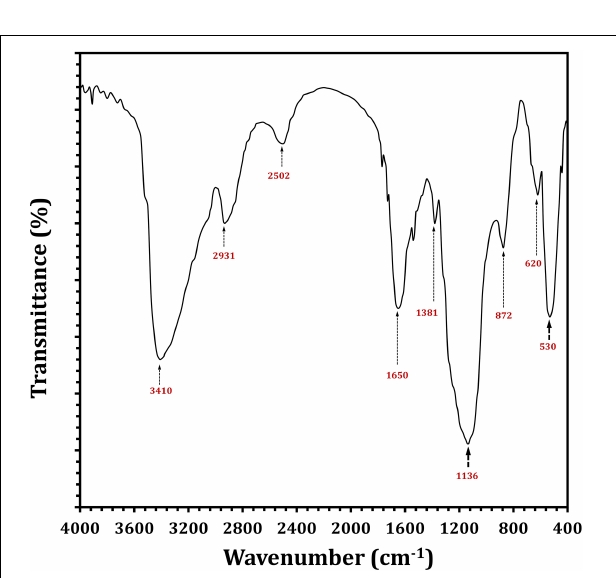
Figure 6 | FTIR spectra of L. delbrueckii ssp. bulgaricus DSM 20081 T -derived EPS 5 .